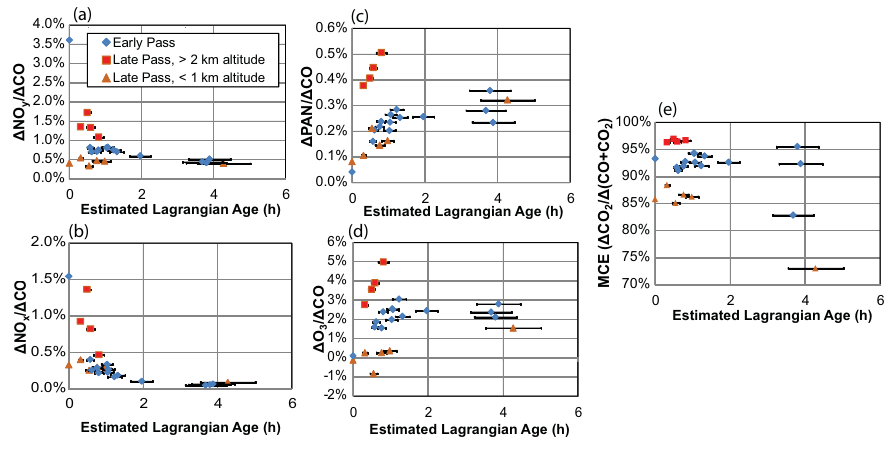
Fig. 3. Enhancement ratios of (a) NO y , (b) NO x , (c) PAN, and (d) O 3 and (e) modified combustion efficiency (MCE) versus Lagrangian age for the Lake McKay smoke plume sampled during the 1 July flight of the DC8. Blue diamonds are for samples taken during the early pass (13:00–15:00LT), while red squares and orange triangles are for samples taken during the late pass (18:20–19:40LT) above 2km and below 1km in altitude,